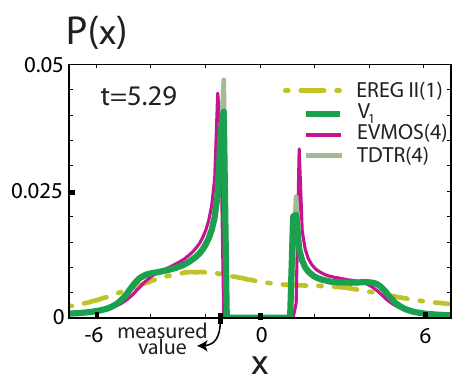
Fig. 16. Probability distributions of the variable x at time t = 5 : 29 for the ensembles generated as specified in Fig. 15. We used 10 7 ensemble members. It is clear that the EREG II distribution is not bimodal as are the others.